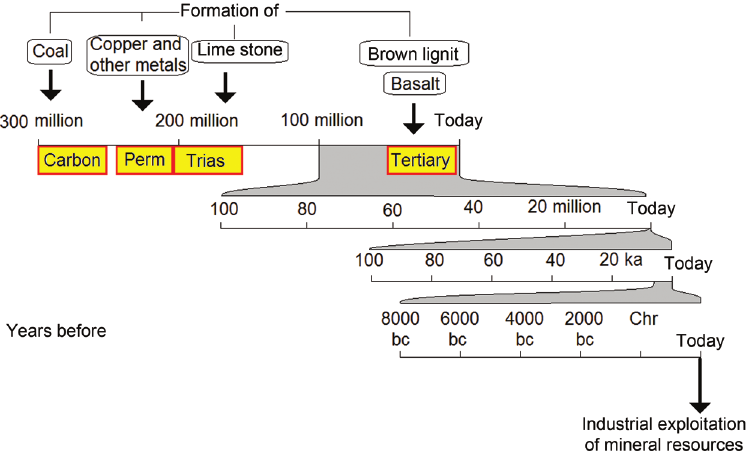
Figure 3 Extraordinary time-scale violation by nonreversible exploitation of fossil energy